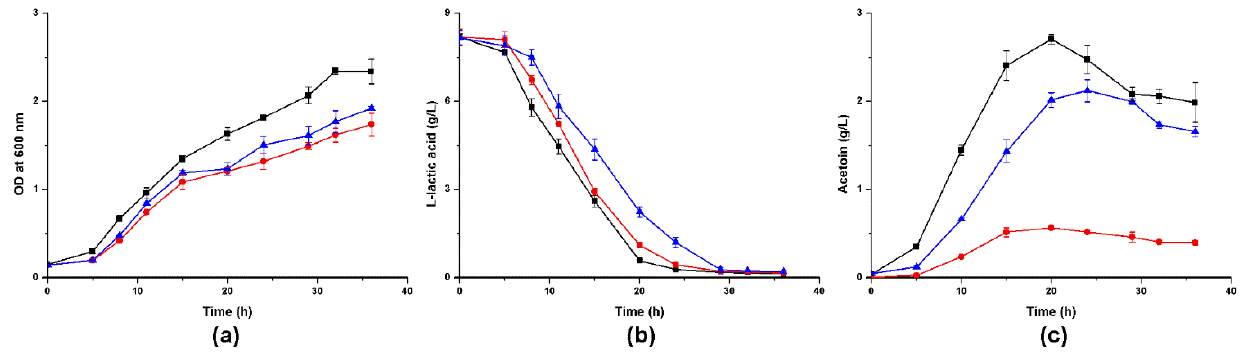
Figure 5. Time course of the cell growth ( a ), lactic acid consumption ( b ), and acetoin production ( c ) in LYSE media by A. pasteurianus CICC 22518 (square), 22518- ΔalsS1 (circle) , and 22518- ΔalsS2 (uptriangle). Data were expressed as mean ± standard errors of three replicates.